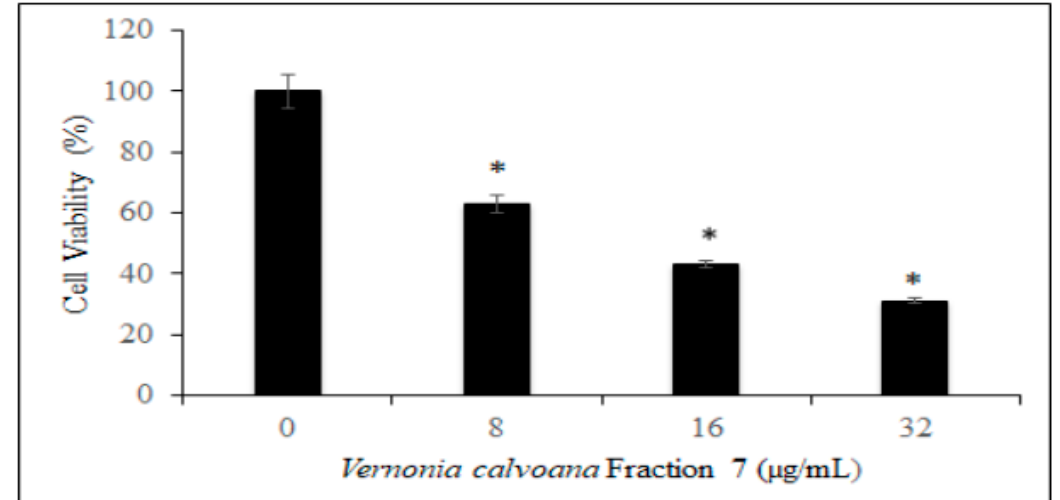
Figure1. Antiproliferativee ff ectof Vernoniacalvoana fraction7(VCF7)onOVCAR-3cells. TheOVCAR-3 Figure 1. Antiproliferative effect of Vernonia calvoana fraction 7 (VC F7) on OVCAR-3 cells. The cells were treated with di ff erent doses of VC F7 for 48 h. The cell viability was measured by MTS assay OVCAR-3 cells were treated with different doses of VC F7 for 48 hours. The cell viability was as described in the Materials and Methods section. Each data point represents the mean value and measured by MTS assay as described in the Materials and Methods section. Each data point standard deviation ( n = 3). * Asterisks denote a statistically significant di ff erence ( p < 0.05) between the represents the mean value and standard deviation ( n = 3). * Asterisks denote a statistically significant control and the treated groups according to the ANOVA Dunnett test. difference ( p < 0.05) between the control and the treated groups according to the ANOVA Dunnett test.